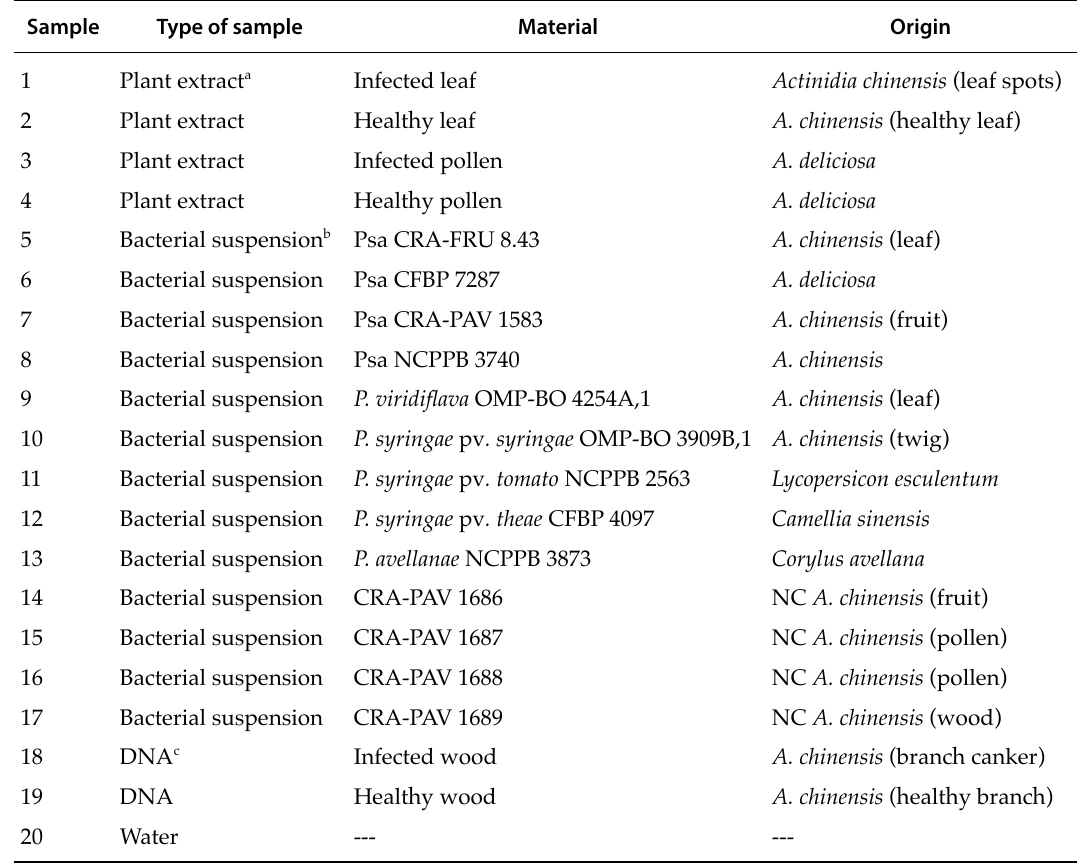
Table 1. Constitution of the 20 samples used within each set of samples assayed by different laboratories for bacterial